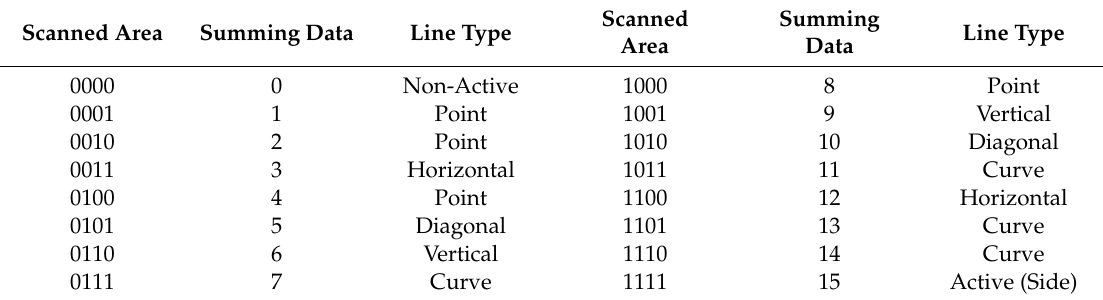
Table 1. Type and sum of lines according to the scanned